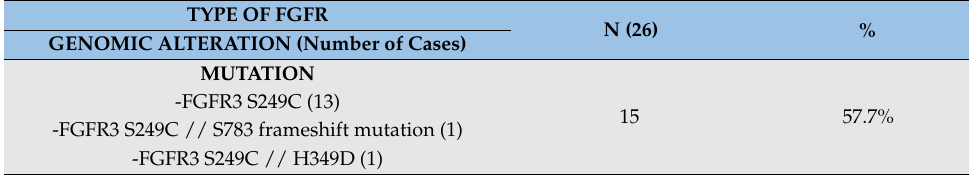
Table 2. FGFR genomic